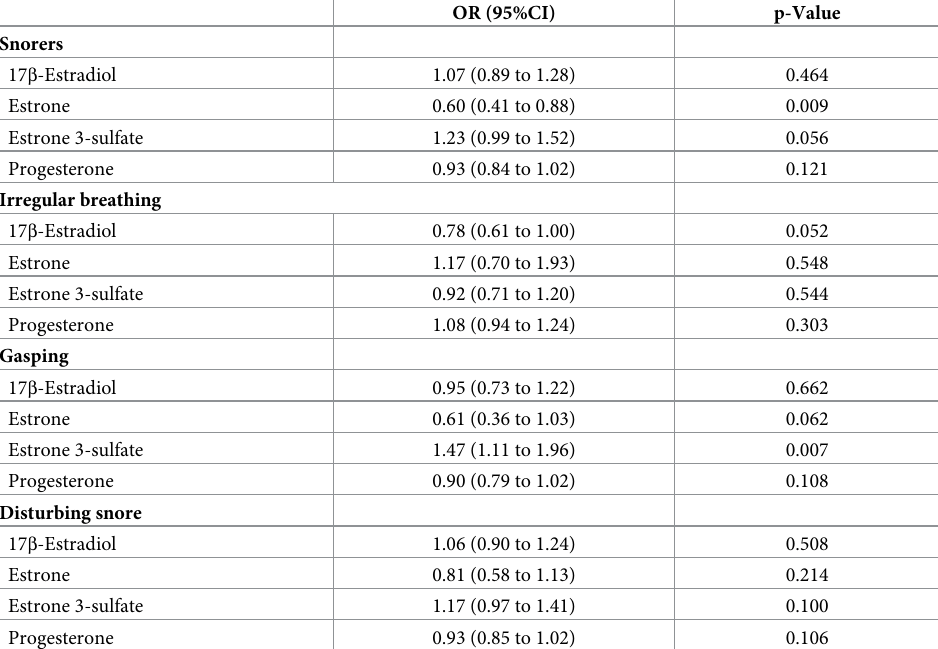
Table 3. Odds ratio and 95% Confidence interval for a model with adjustment for all measured female sex hor- mones, age, BMI, smoking, age at completed full time education, study center and reproductive aging